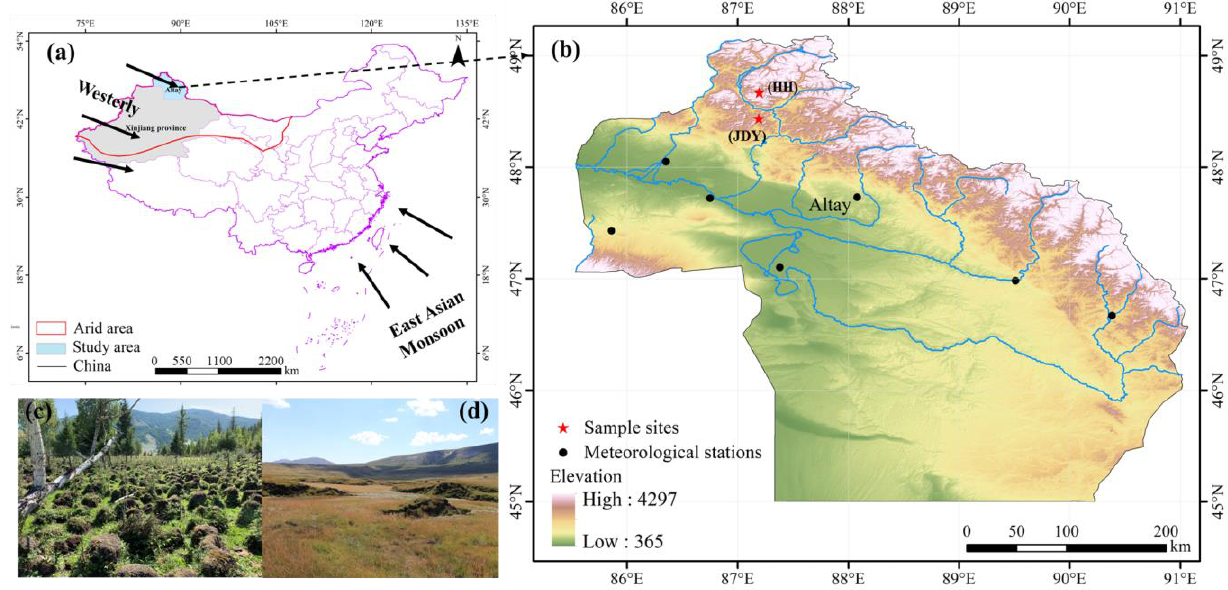
Figure 1. Geographical position of the sampling sites and an environmental overview of the peatlands (( a ) denotes a map of China showing the locations of Jiadengyu and Heihu in northwest China and the Asian monsoon and the westerly; ( b ) represents the locations of Jiadengyu and Heihu peatlands (red five-pointed stars); ( c , d ) denote the photos showing the summer scene in the studied peatlands in August 2019).